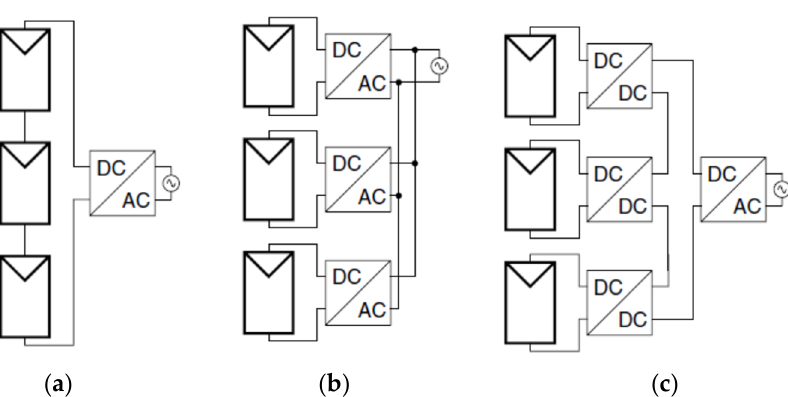
Figure 29. Distributed MPPT sub-string architectures: Module-Integrated Converter ( a ); subMIC architecture ( b ); Cascaded substring dc–dc architecture plus module micro-inverter ( c ).